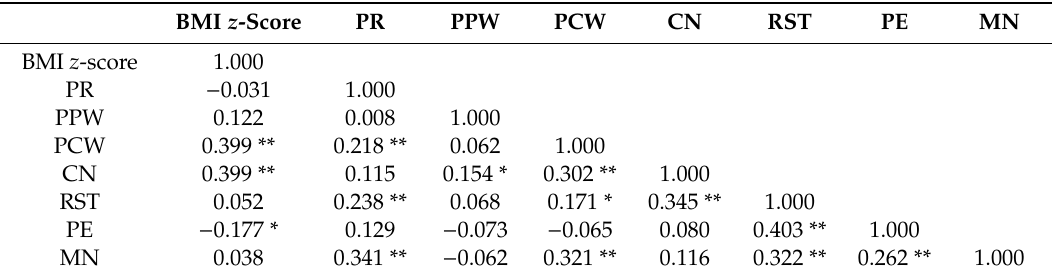
Table 3. Pearson’s correlations between CFQ factors and BMI z -score.